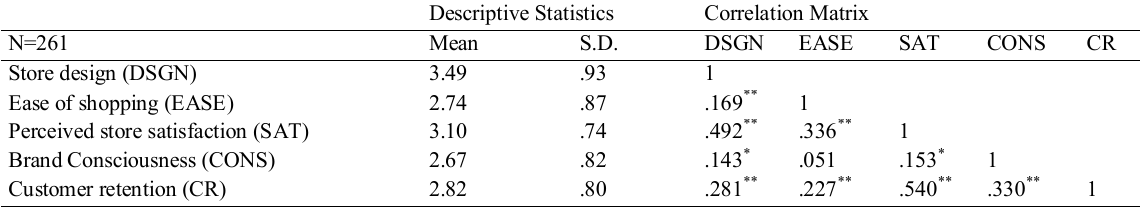
Table 1. Study Data Descriptive Statistics and Correlation Matrix (Brand F) Descriptive Statistics Correlation Matrix